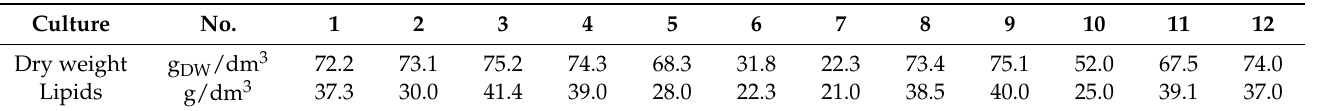
Table 7. Biomass and lipid concentration in the S. limacinum E20 culture as a function of the tested parameters.